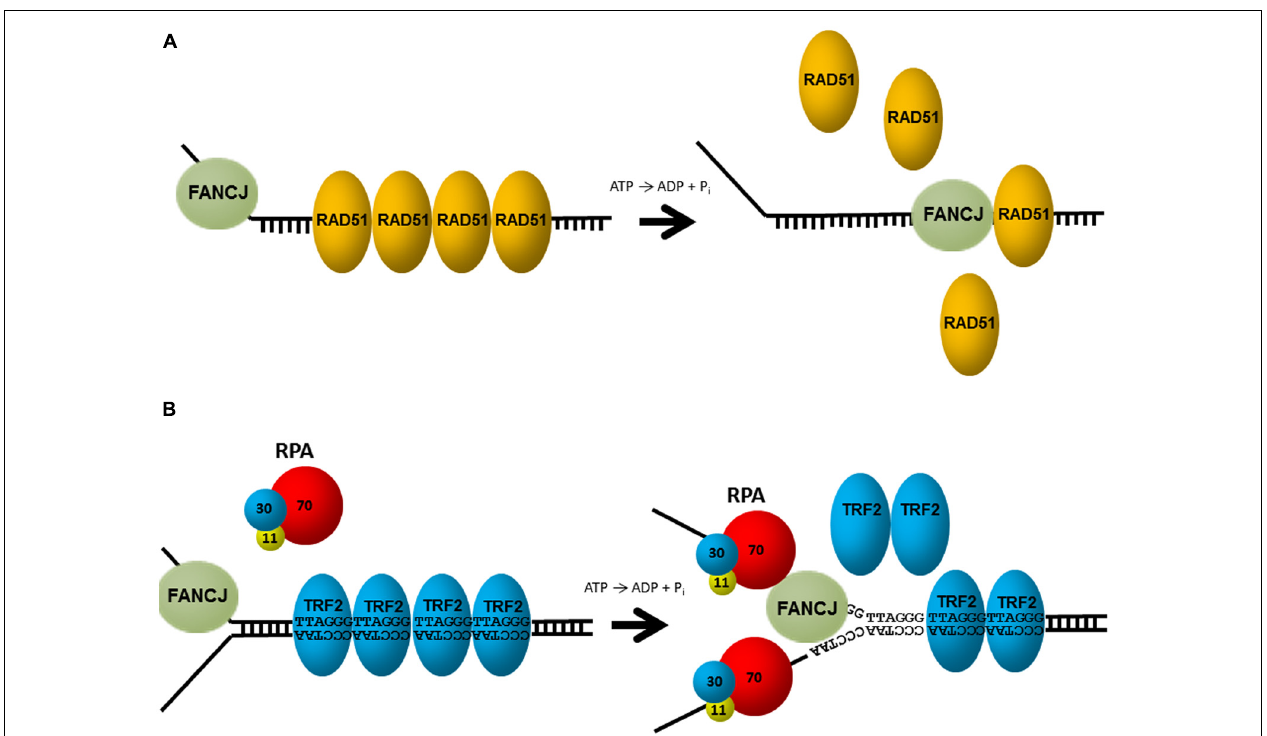
FIGURE 4 | FANCJ uses its motor ATPase to displace proteins bound to DNA. (A) FANCJ catalytically displaces the major DNA recombinase protein RAD51. See reference Sommers etal. (2009) and text for details.